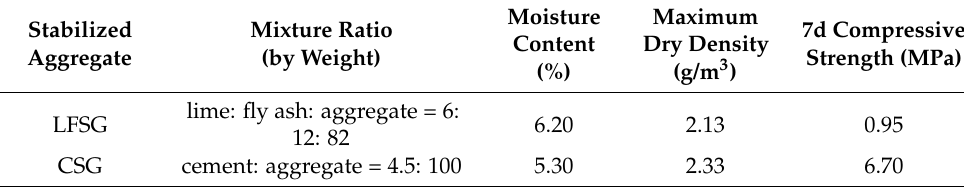
Table 7. Mixture design of LFSG and